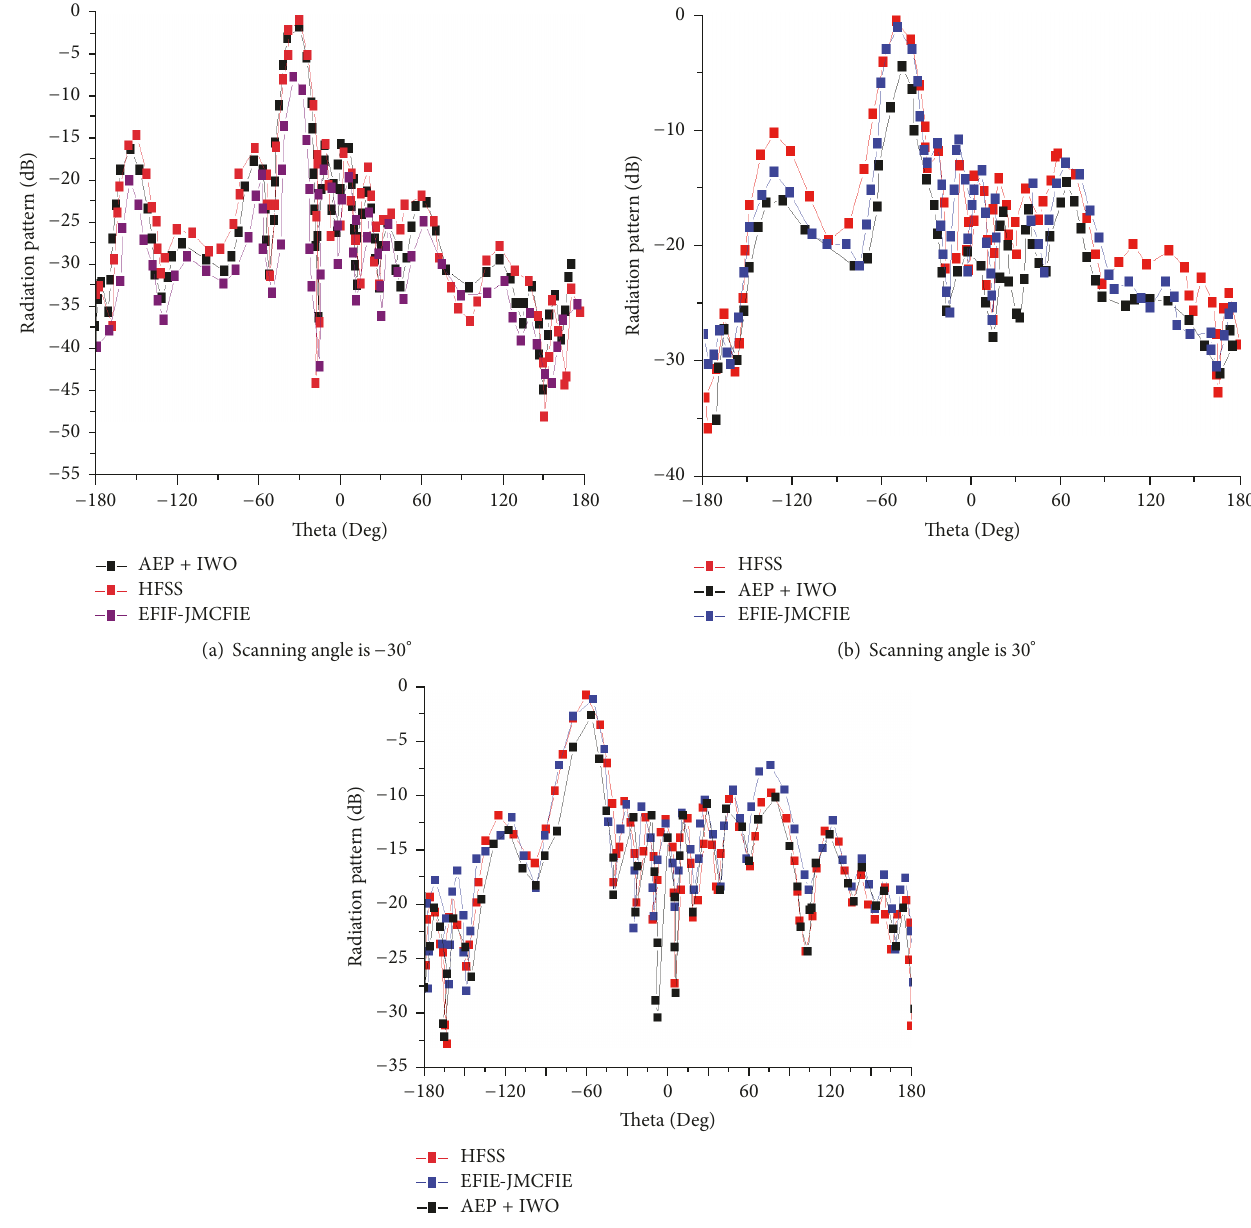
Figure 20: Optimized X-band array direction